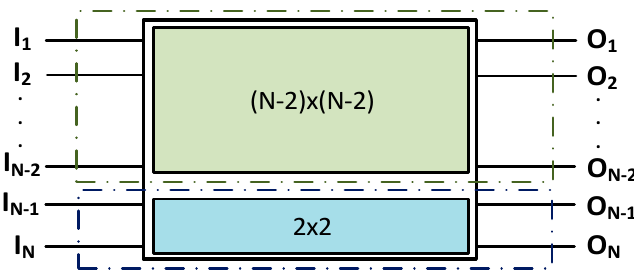
Figure 6. N × N switch divided into two layers of ( N -2)×( N -2) and 2 × 2 .